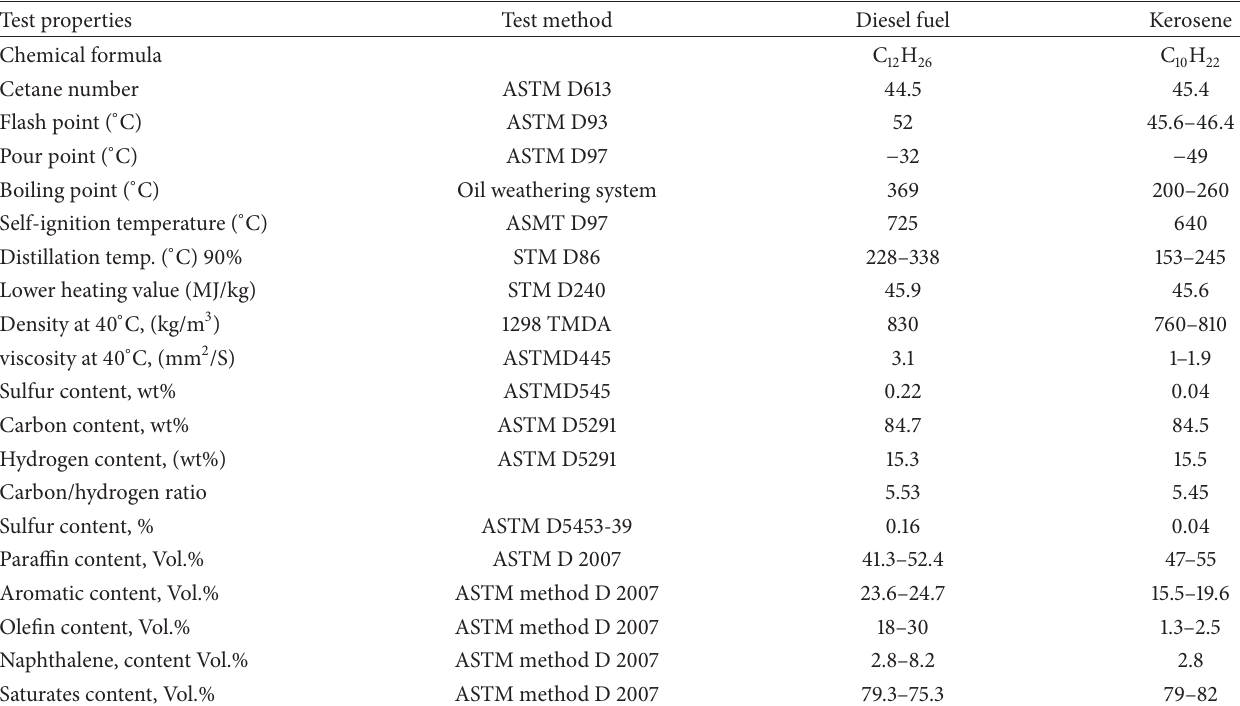
Table 1: Properties of diesel and kerosene